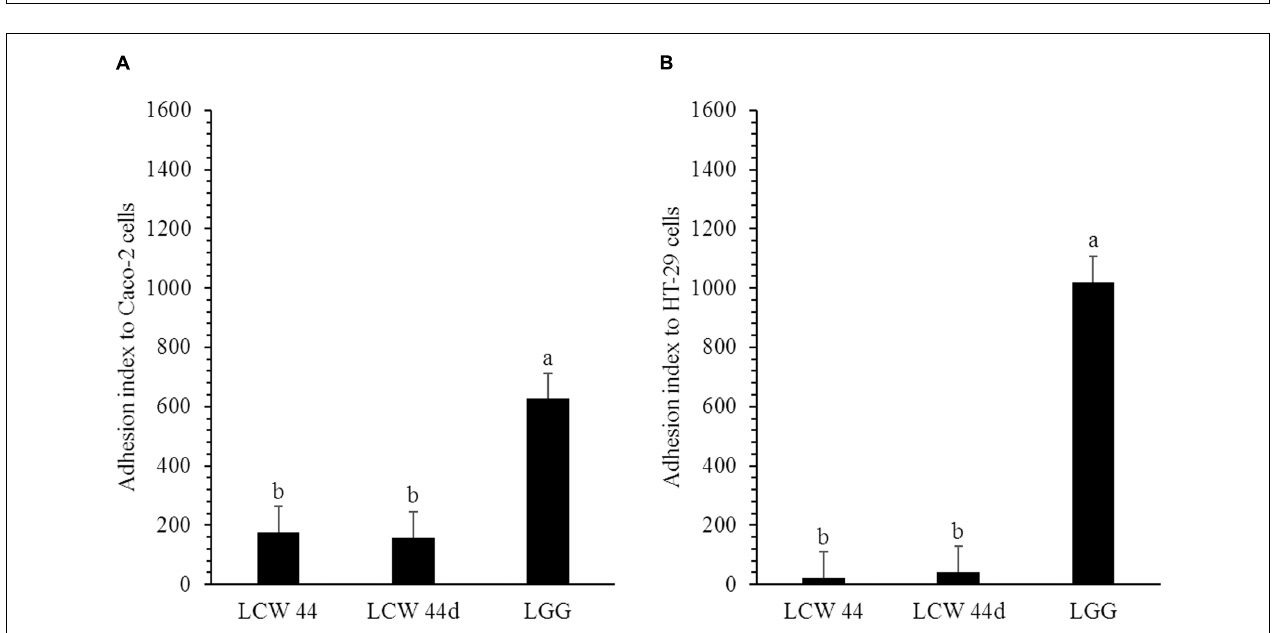
FIGURE 3 | Viability of E. faecium LCW 44 under gastrointestinal conditions (pH and enzymes) in the TIM-1 system. (A) Distribution (%) of the medium (skim milk) in the compartments of the TIM-1 model; (B) Viable count (cfu/mL) determined by plating on agar. Stomach (diamond), duodenum (square), jejunum (circle), ileum (triangle), and efflux (cross). All values are the means of two independent experiments. Error bars indicate the standard error of the mean.